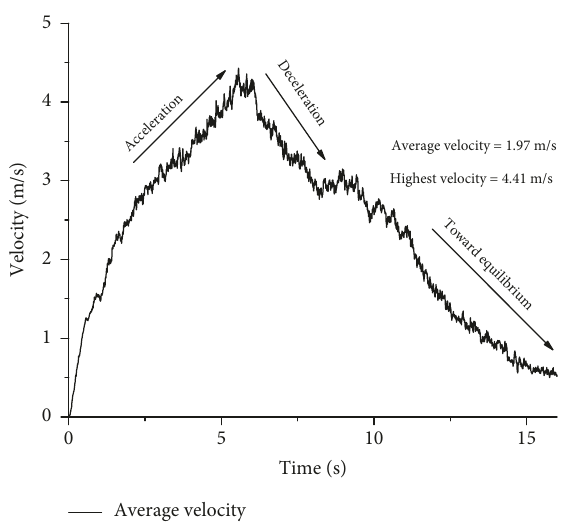
Figure 15: The average velocity of the landslide before colliding the reference